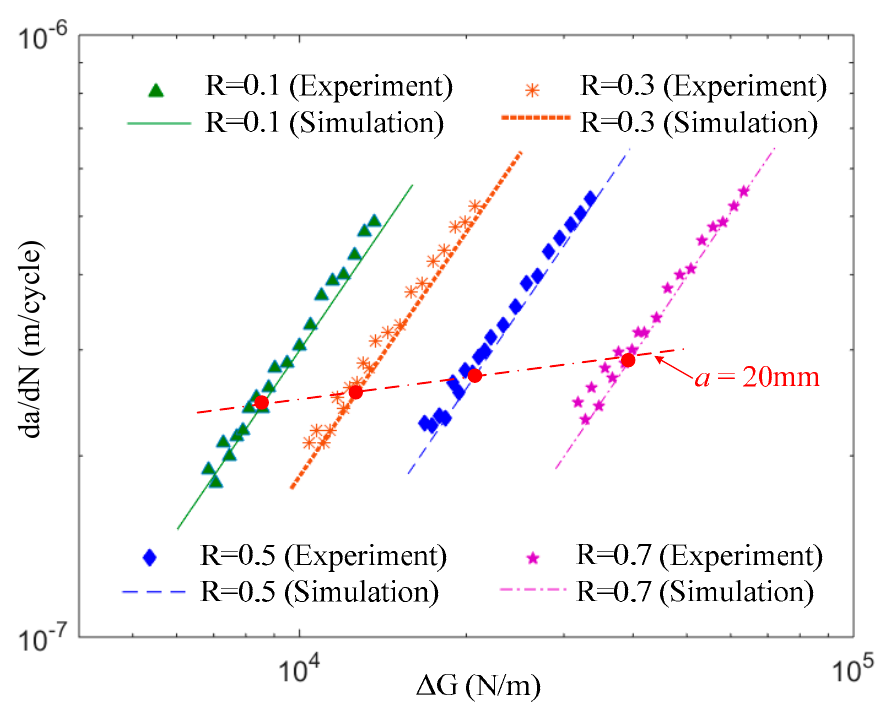
∆ G curves at R ratios of 0.1, 0.3, 0.5 and Figure 11. da/dN −Δ G curves at R ratios of 0.1, 0.3, 0.5 and 0.7. Figure 11. da/dN −